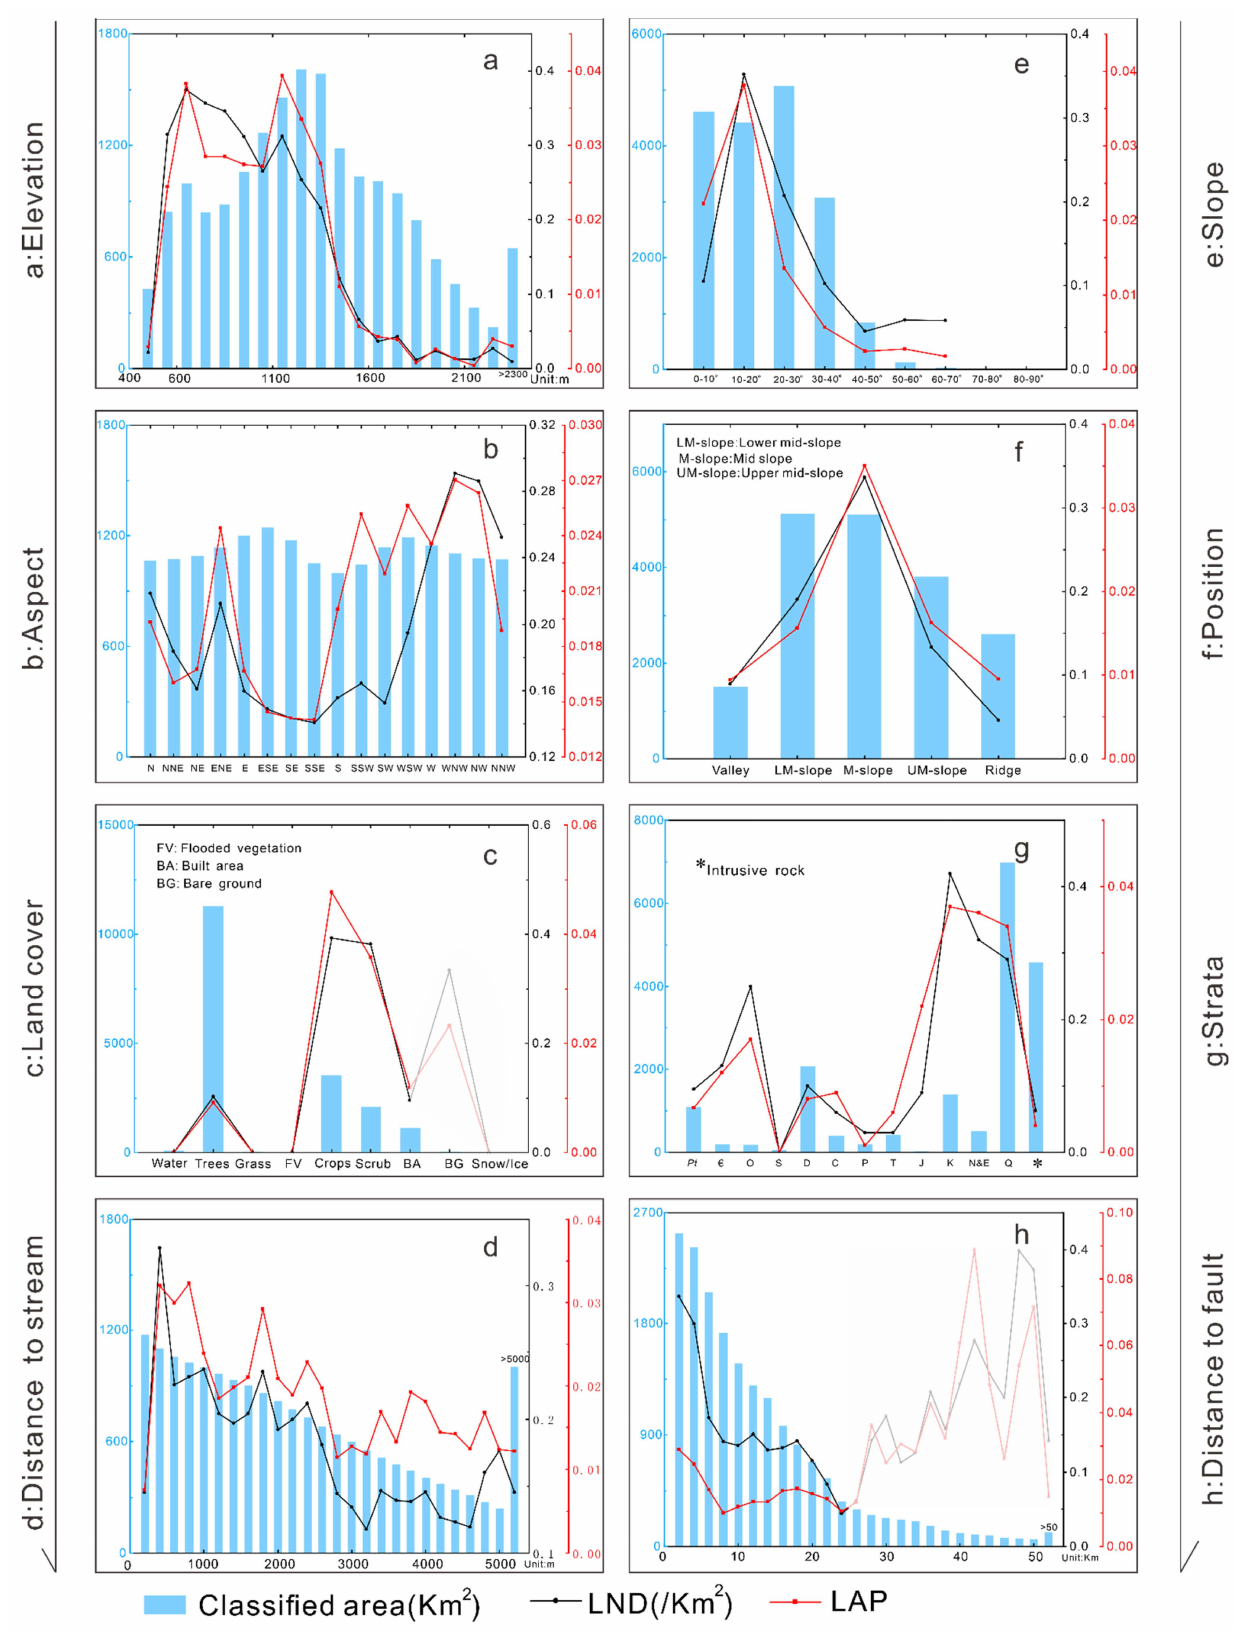
Figure 16. Classified areas of eight influencing factors in the study area (blue bars) and curves of LND and LAP versus these